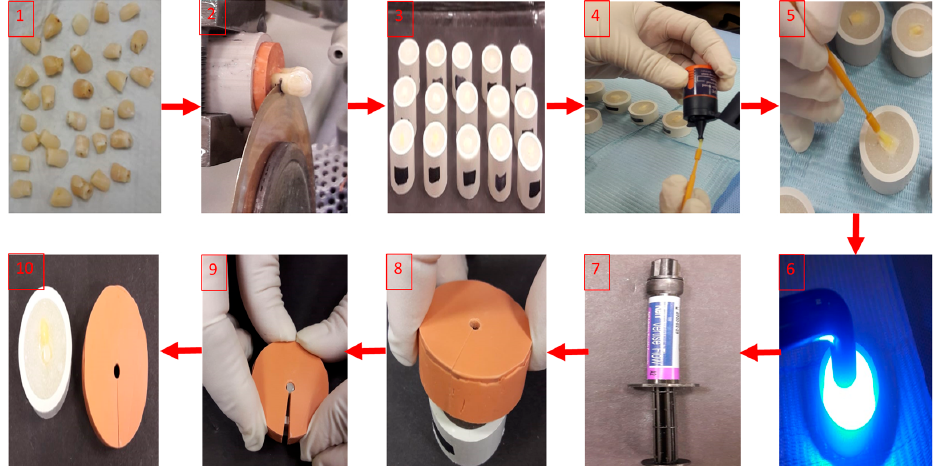
Figure 1. Stepwise flow diagram of sample preparation: (1): teeth inspection for defects; (2) re- moval of enamel to expose dentin by sectioning the teeth; (3) embedding teeth in resin in a plastic mold (2 × 2 inch 2 ) and surface smoothening; (4,5) applying adhesive to dentin; (6) irradiation of adhesive; (7) flowable composite packing; (8) polyvinyl siloxane putty with 3.0 mm × 3.0 mm (H × D) dimensions positioned on dentin; (9) filling of flowable composite for build-up; (10) removal of mold.